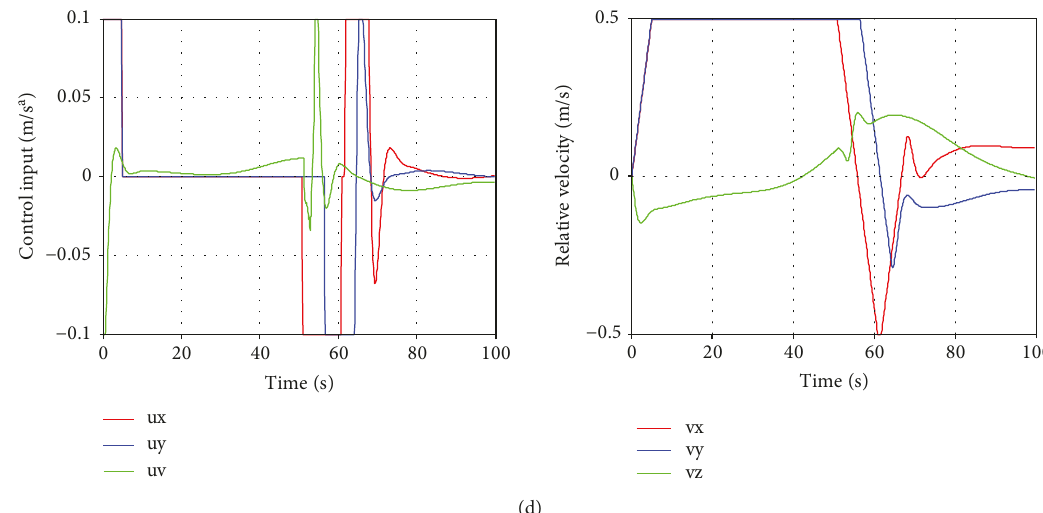
Figure 12: Temporal response of the control input (left) and relative velocities (right) for (a) Sat 1, (b) Sat 2, (c) Sat 3, and (d) Sat 4.